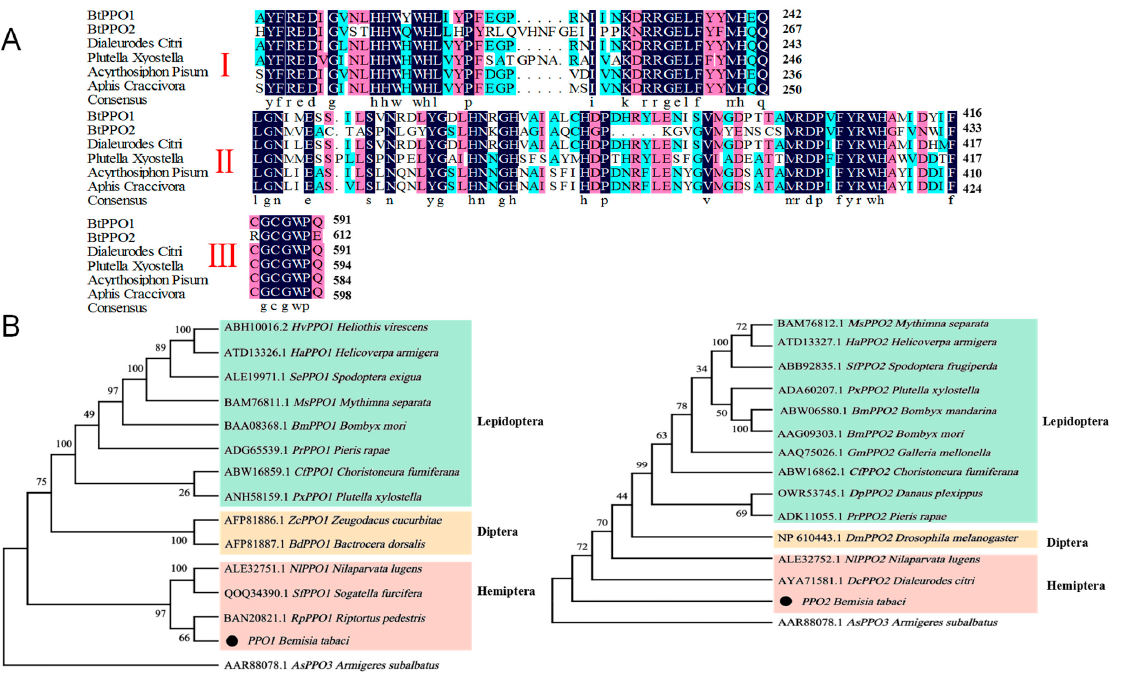
Figure 1. Comparison of prophenoloxidase genes’ sequences and phylogenetic analysis. ( A ) Align- ments of the deduced amino acid sequences of prophenoloxidase genes in Bemisia tabaci with other insects. Hyphens (-) are used to indicate regions where gaps have been introduced to maximize homology. ( B ) Phylogenetic trees of prophenoloxidase genes with other insect prophenoloxidases. The black dot represents the deduced amino acid sequences of prophenoloxidase genes in Bemisia tabaci . The cladogram was constructed by MEGA software using the neighbor-joining method. Ar- migeres subalbatus prophenoloxidase-3 gene was used as an outgroup ( Dialeurodes citri : AYA71581.1; Plutella xyostella : ACS36209.1; Acyrthosiphon pisum : XP_001949307.1; Aphis craccivora : KAF0771674.1). Region I: copper binding site A (Cu A ), region II: copper binding site B (Cu B ), and region III: thiol ester region-like motif. Note: identical amino acids (equal to 100%) are framed by the filled dark blue boxes, identical amino acids (greater than or equal to 75%) are framed by the filled pink boxes, and identical amino acids (greater than or equal to 50%) are framed by the filled light blue boxes. 2.2. Spatiotemporal Expression Profiles of BtPPOs in Bemisia Tabaci The RT-qPCR results showed that BtPPO1 had the highest expression in the abdomen (Figure 2A), and in the developmental stages, the expression of BtPPO1 increased from egg to third instar nymph. Expressions of BtPPO1 were highest in the second to third nymphs (Figure 2B), while the BtPPO2 had the highest expression in the head. Both of the genes had the lowest expression levels in the thorax (Figure 2C). Interestingly, the BtPPO2 had the highest expression in egg and decreased from the first nymphs to the fourth nymphs (Figure 2D). The same phenomenon was seen, where both BtPPO1 and BtPPO2 had higher expression in female adults than in male adults.